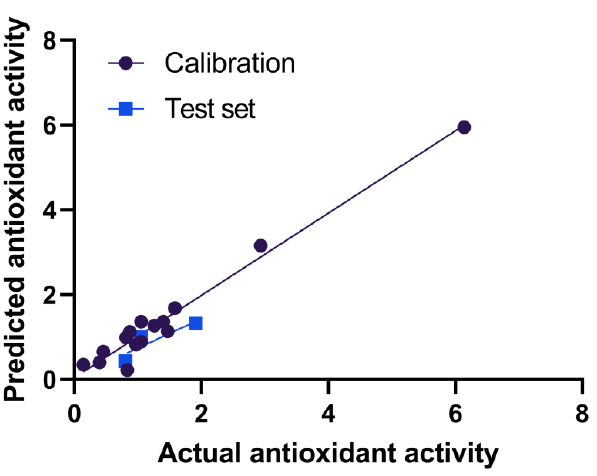
Figure 9. The prediction results for total antioxidant activity using multiple linear regression. The black points show the calibration set and the blue points show the test set.